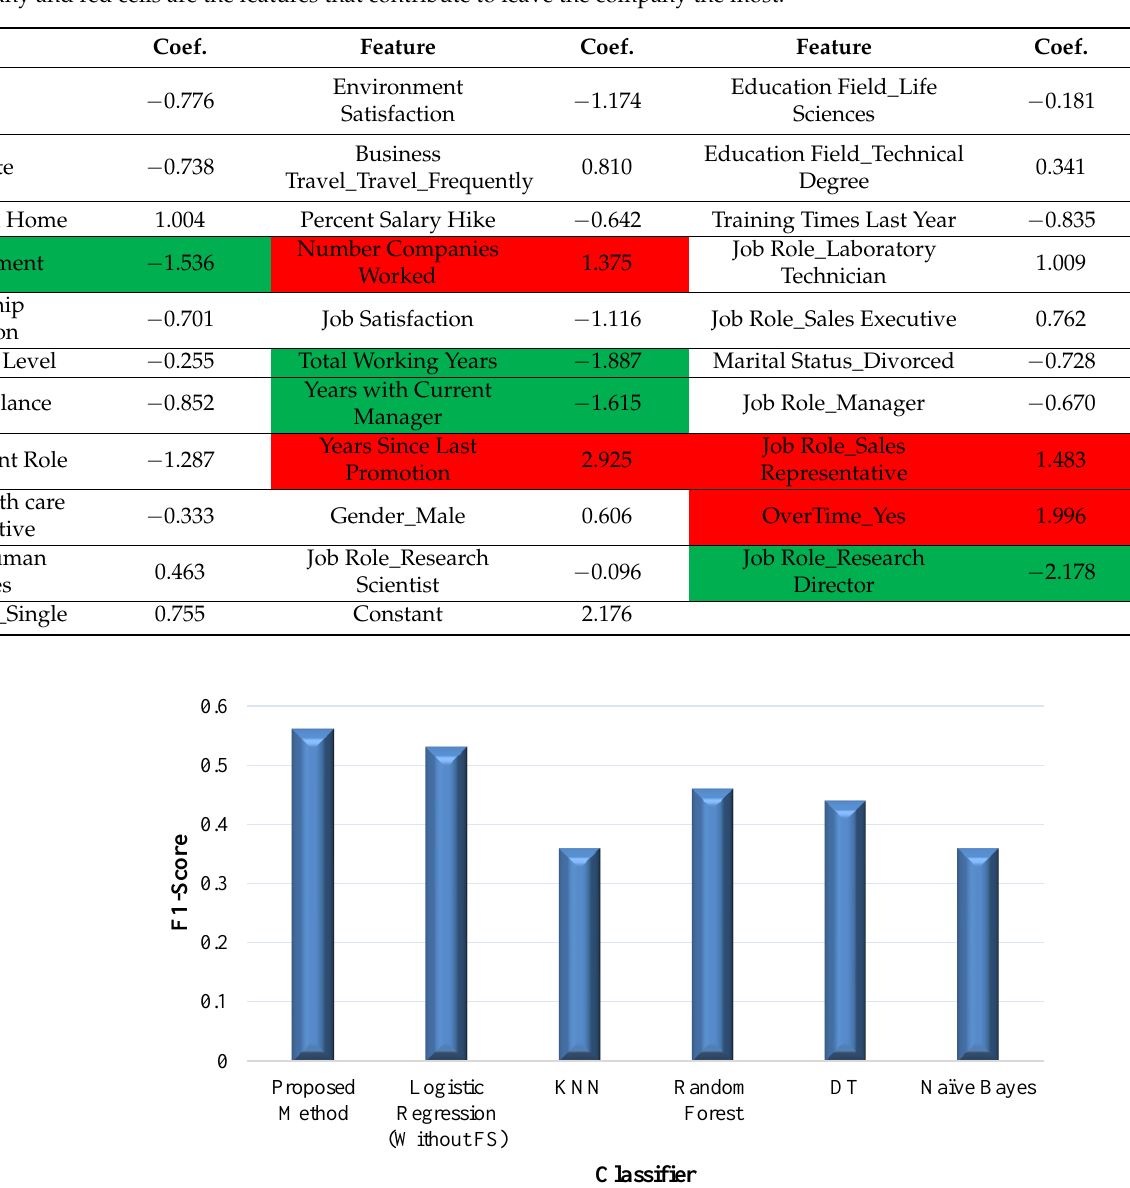
Figure 6. Comparison of Different Classifiers’ Performance Measures for the HR Attrition Predic- tion Task.